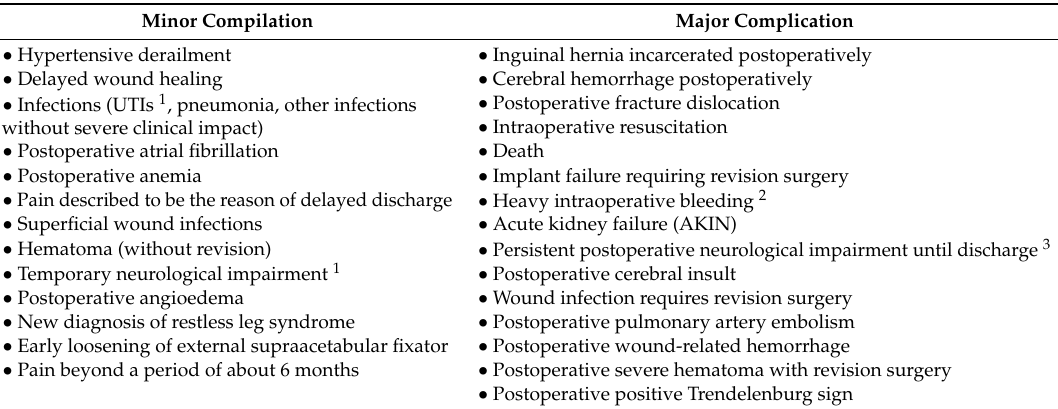
Table 1. Minor and major